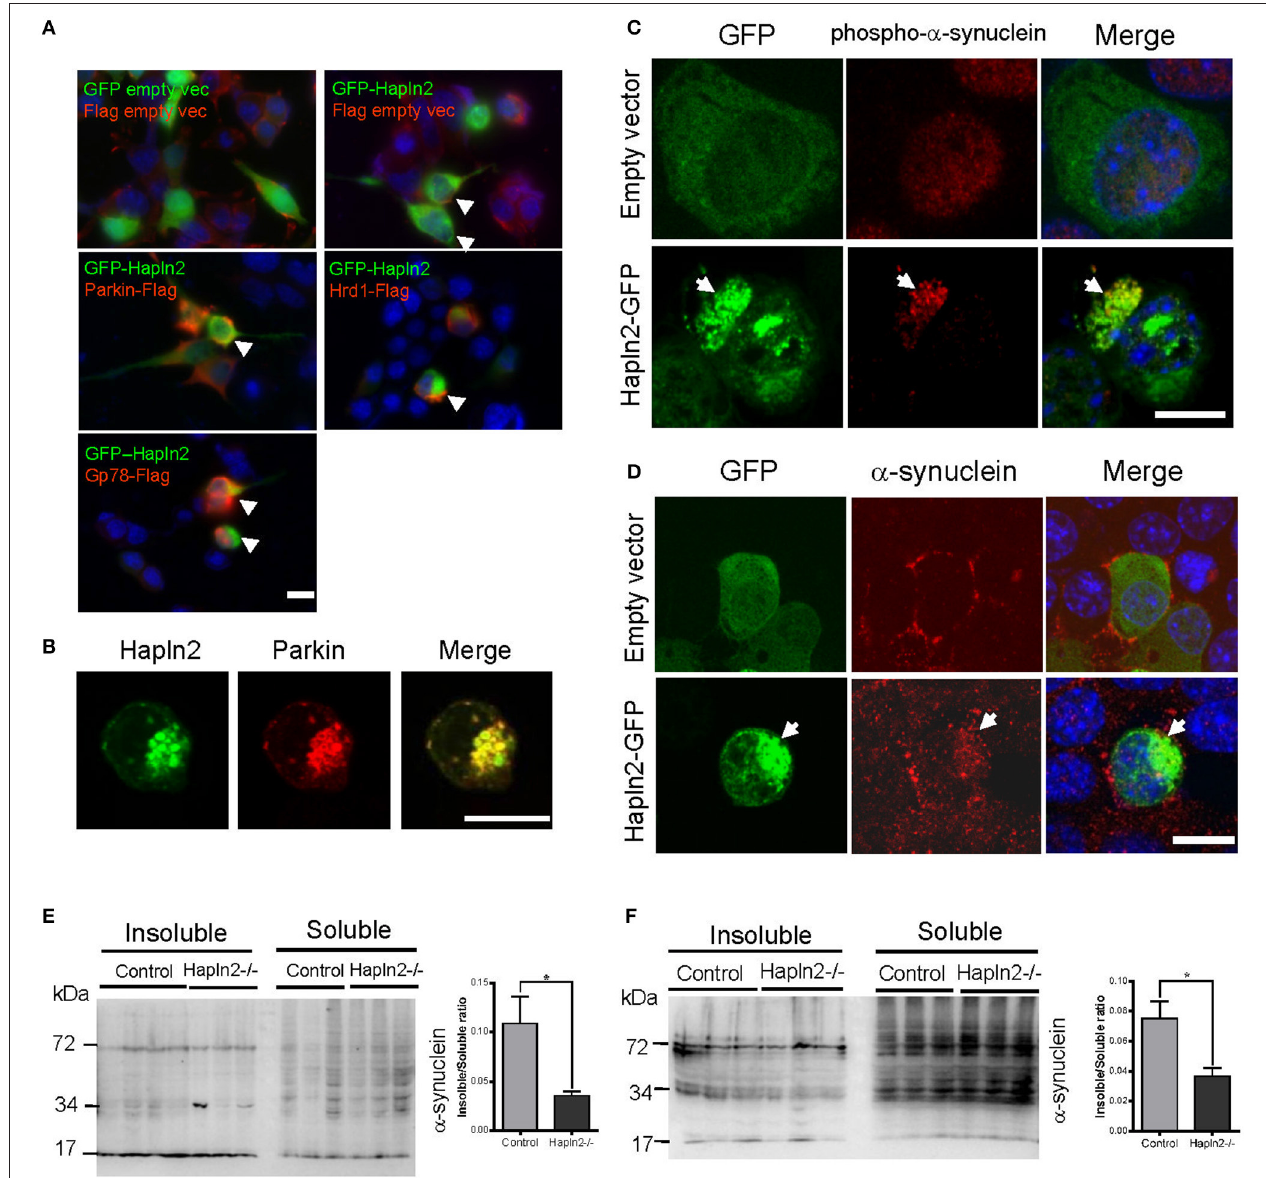
FIGURE 6 | Exogenous Hapln2-GFP is co-localized with E3 ubiquitin ligases and α -synuclein. (A) Immunofluorescent staining co-localization of Hapln2 and E3 ubiquitin ligases including Parkin, Hrd1, Gp78 in vitro. Arrow heads point to the merged cells. (B) Immunofluorescent staining showing the co-localization of Hapln2 with Parkin (C418R). (C,D) Representative micrographs showing co-localization of Hapln2-GFP and phosph- α -synuclein (C) or α -synuclein (D) in MES23.5 cells transfected with Hapln2-GFP plasmids. Arrows indicate the colocalization of Hapln2 and phospho- α -synuclein (C) or α -synuclein (D) . Scale bars = 10 µ m. (E,F) Expression levels of RIPA-soluble and urea-soluble protein fractions extracted from SN (E) and cerebellum (F) . Data are expressed as mean ± S.E.M. ( n = 3). * p < 0.05.